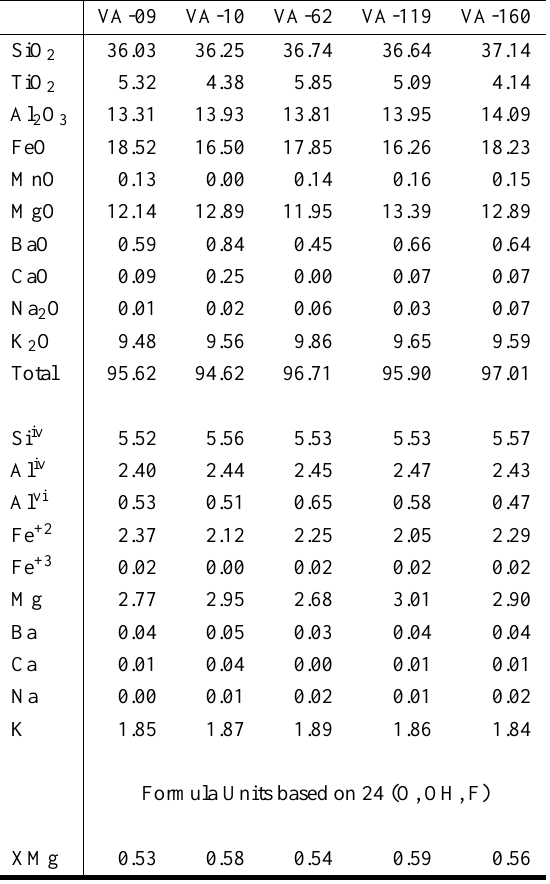
Representative Microprobe analyses of